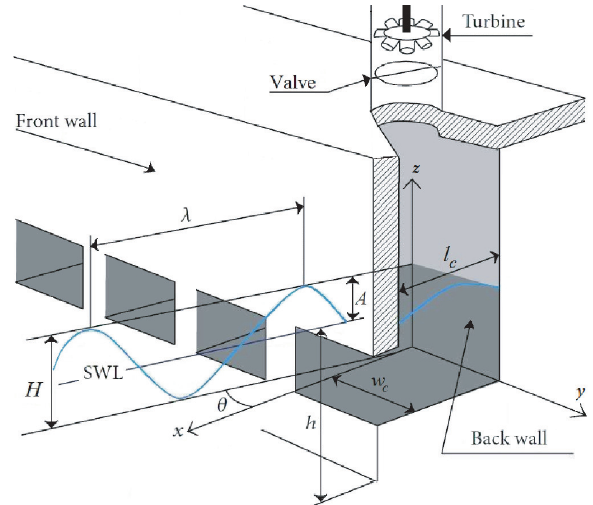
Figure 2. Scheme of the OWC station and the sea wave. SWL, Still Water